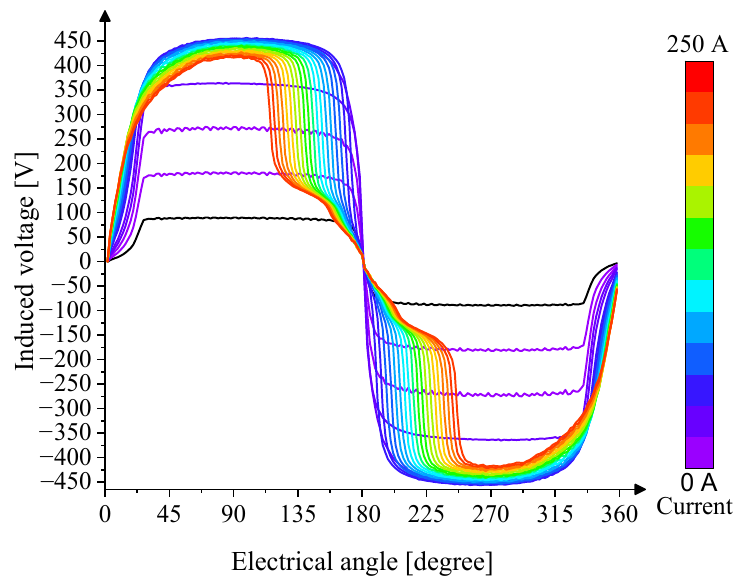
Figure 20. Static voltage waveform at 2600 rpm for different current references.